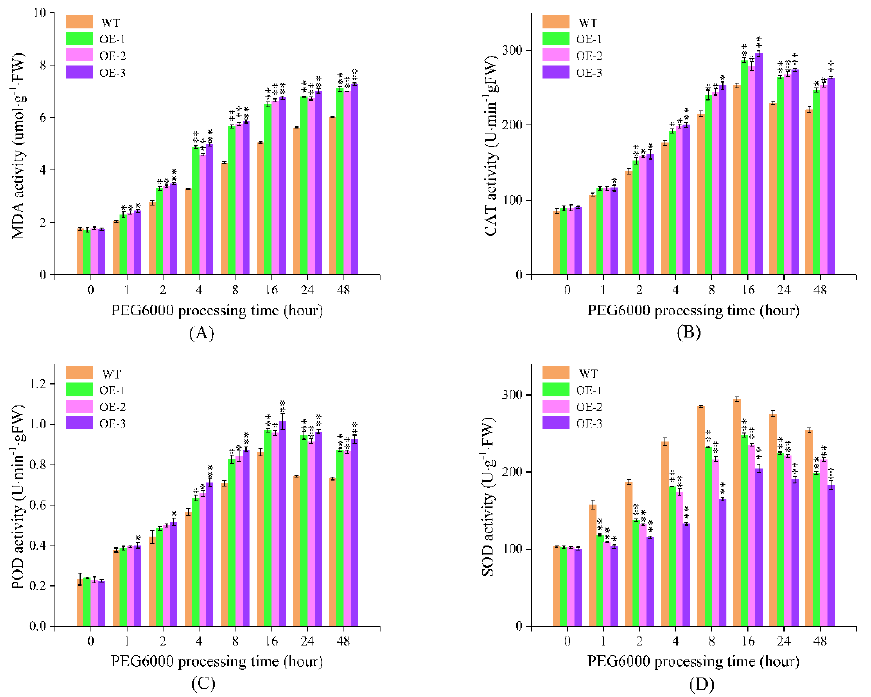
Figure 7. Determination of activity of MDA, CAT, POD and SOD after irrigation with 20% PEG6000. ( A ) The content of MDA, ( B ) the enzyme activity of CAT, ( C ) the enzyme activity of POD, ( D ) the enzyme activity of SOD. Three independent biological samples of three technical replicates for RT-PCR analysis. Each column represents the mean values ± SE ( n = 3; * p < 0.05; ** p <